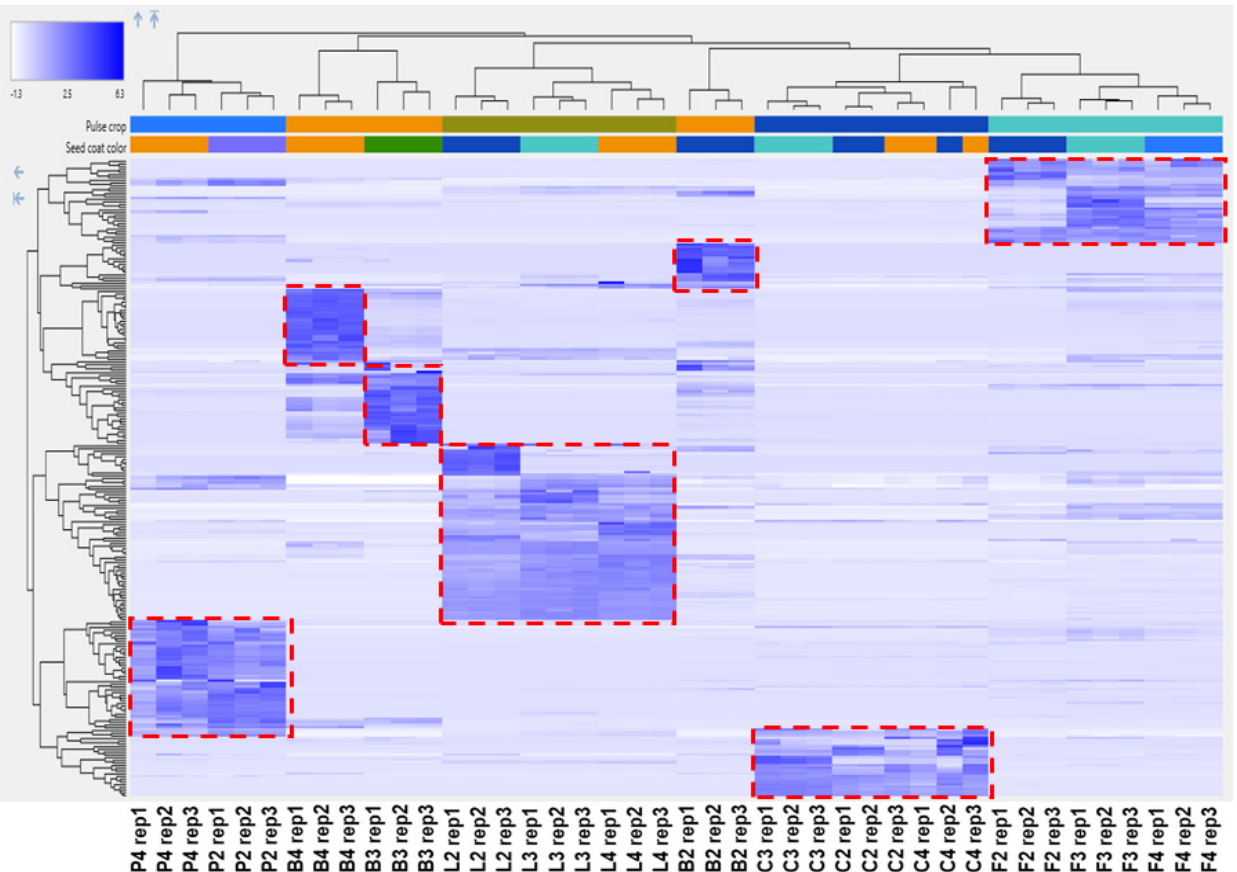
Figure 5. Heat map of hierarchal clustering analysis (HCA) showing separate clusters for seed coat samples.